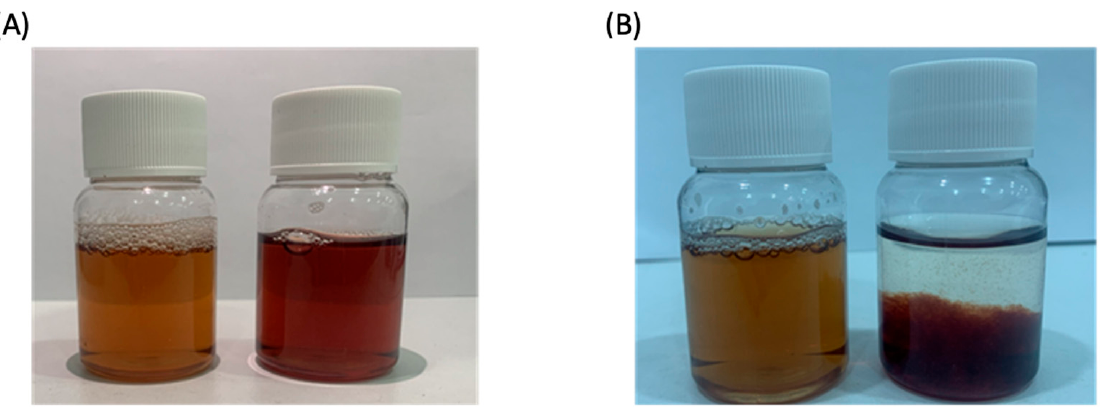
Figure 2. Chemical encapsulation of AGSE improves color and solubility. Comparison of 0.2% AGSE propylene glycol solution (left) and 2% E-AGSE (right) after ( A ) initial mixing and ( B ) 24 h. 3.2. E-AGSE Upregulates the Expression of Key Anti-Aging Extracellular Matrix Markers